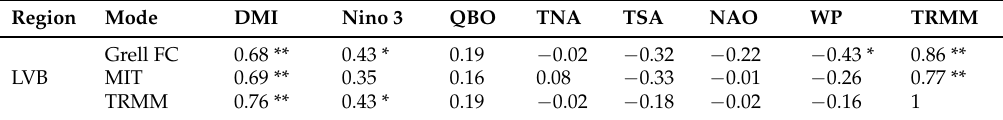
Figure 10. Spatial and temporal distribution for Short Rains EOF1 precipitation from models and observation over Lake Victoria Basin ( a ) Grell FC, ( b ) MIT-Emannuel, ( c ) TRMM, and ( d ) timeseries plot for EOF1. Table 4. Summary of the correlation of TRMM and model output EOF1 with the different indices used in the study for the Short-Rains Season over the Lake Victoria Basin region. The ** indicates correlations that are statistically significant at 95% and * at 90%, significance of correlation was done using a Student’s t